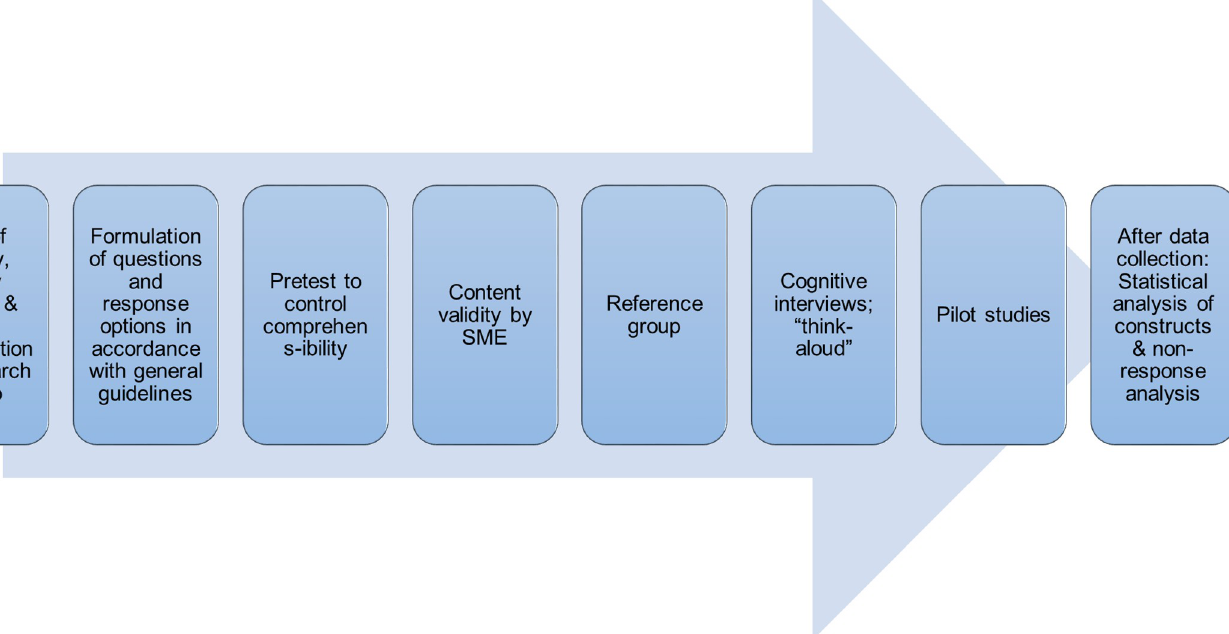
PLOS ONE | https://doi.org/10.1371/journal.pone.0204581 January 25,